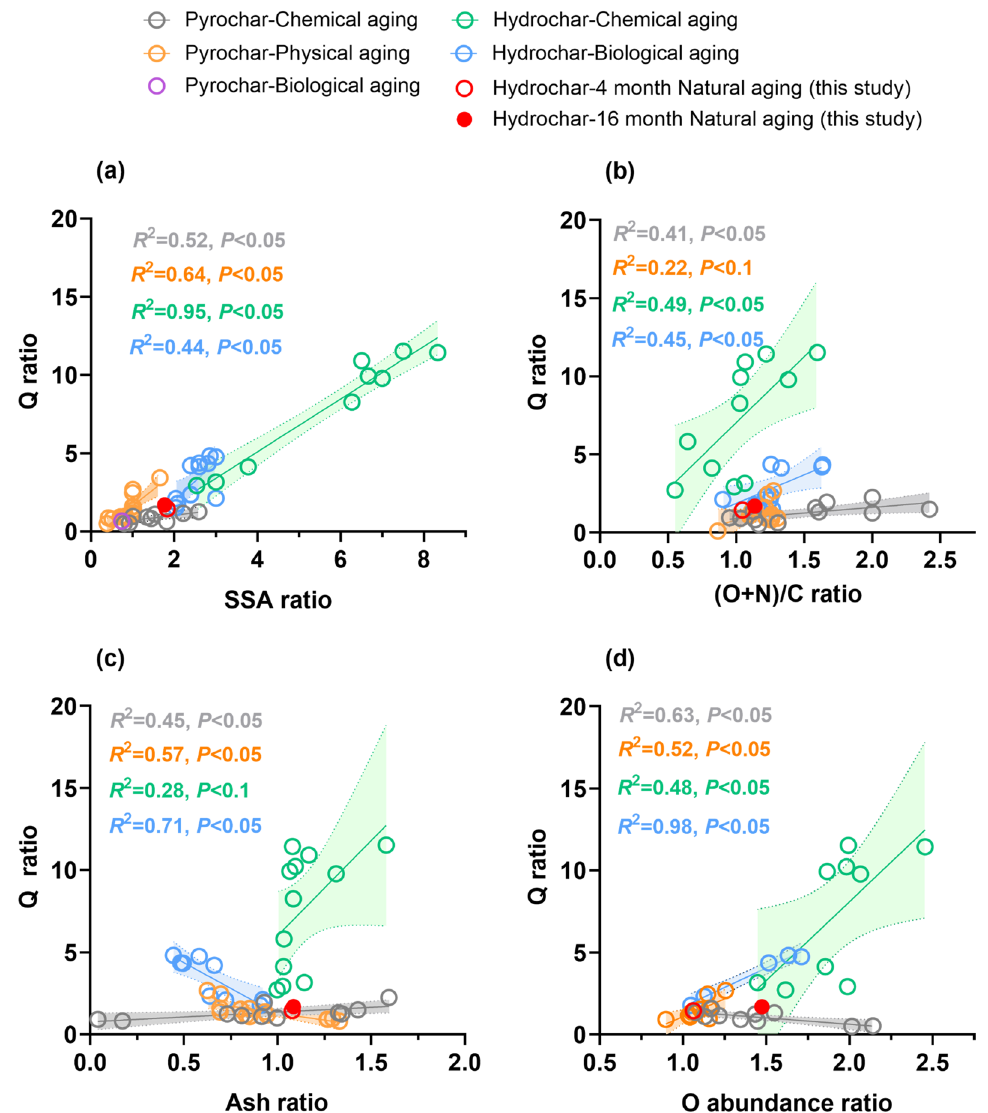
Fig. 5 Correlation of heavy metal sorption capacity with SSA, (O + N)/C, Ash, and O abundance of hydrochar and pyrochar under different aging effects, respectively. The X-axis represents the ratio of each physicochemical property before and after aging. The Y-axis represents the ratio of the corresponding sorption capacity of heavy